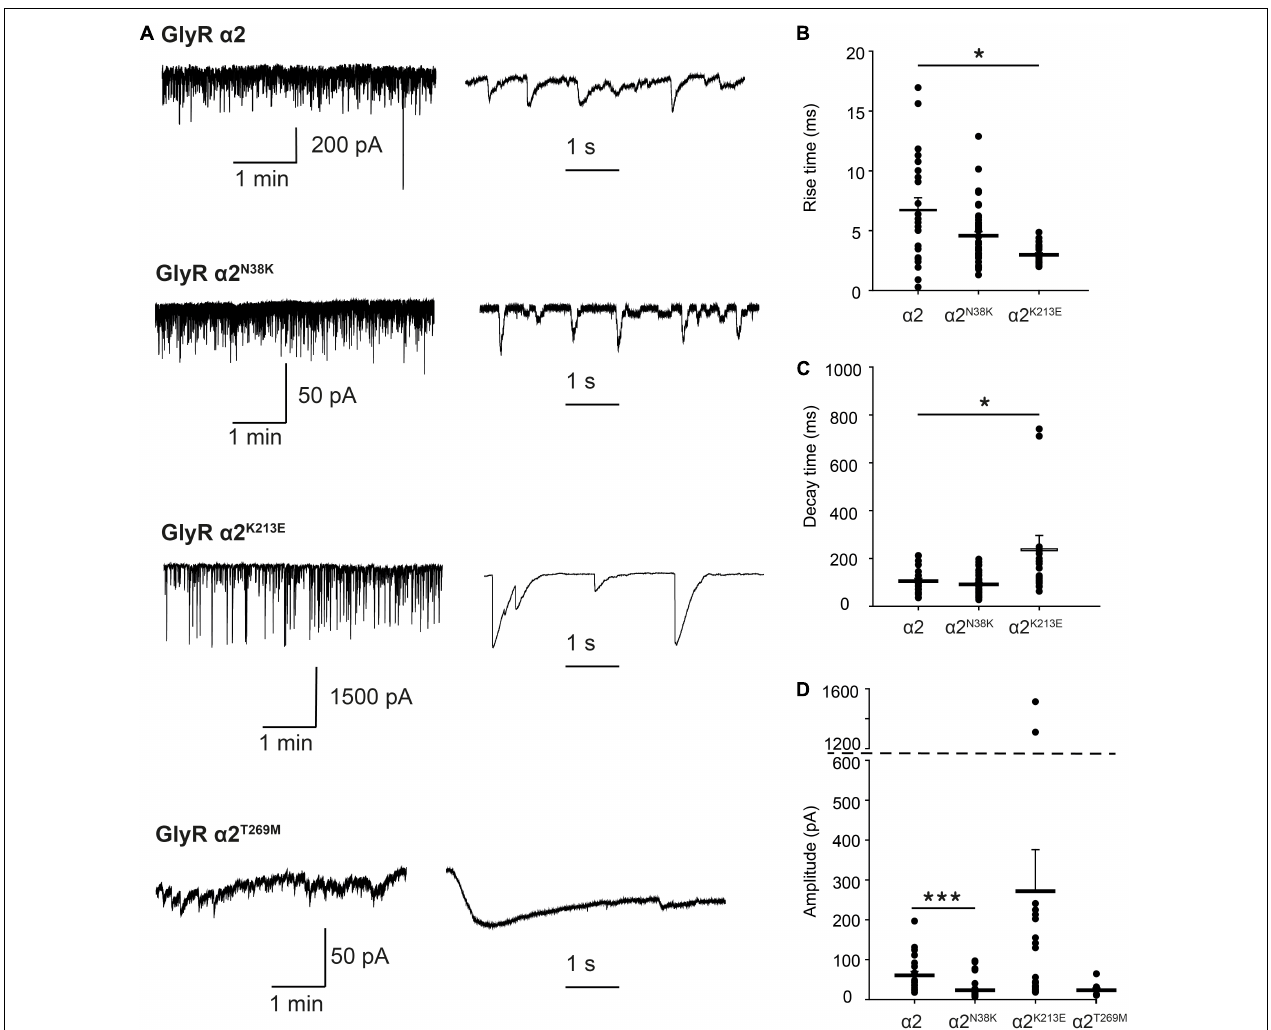
FIGURE 7 | Properties of spontaneous inhibitory postsynaptic currents (IPSCs) recorded from artificial synapses incorporating human GlyR α 2 ASD variants. (A) Representative recordings of IPSCs from HEK293 cells expressing wild-type GlyR α 2 and α 2 N38K , α 2 K213E , and α 2 T269M variants at two temporal scales. (B–D) Mean 10–90% rise times, IPSC decay time constants and amplitudes. Each data point represents the global average of all well-isolated events recorded from a single cell. Means were tested for significance relative to WT using one-way ANOVA followed by Tukey’s post hoc test: * p < 0.05, *** p < 0.001. All results are tabulated in Table 3